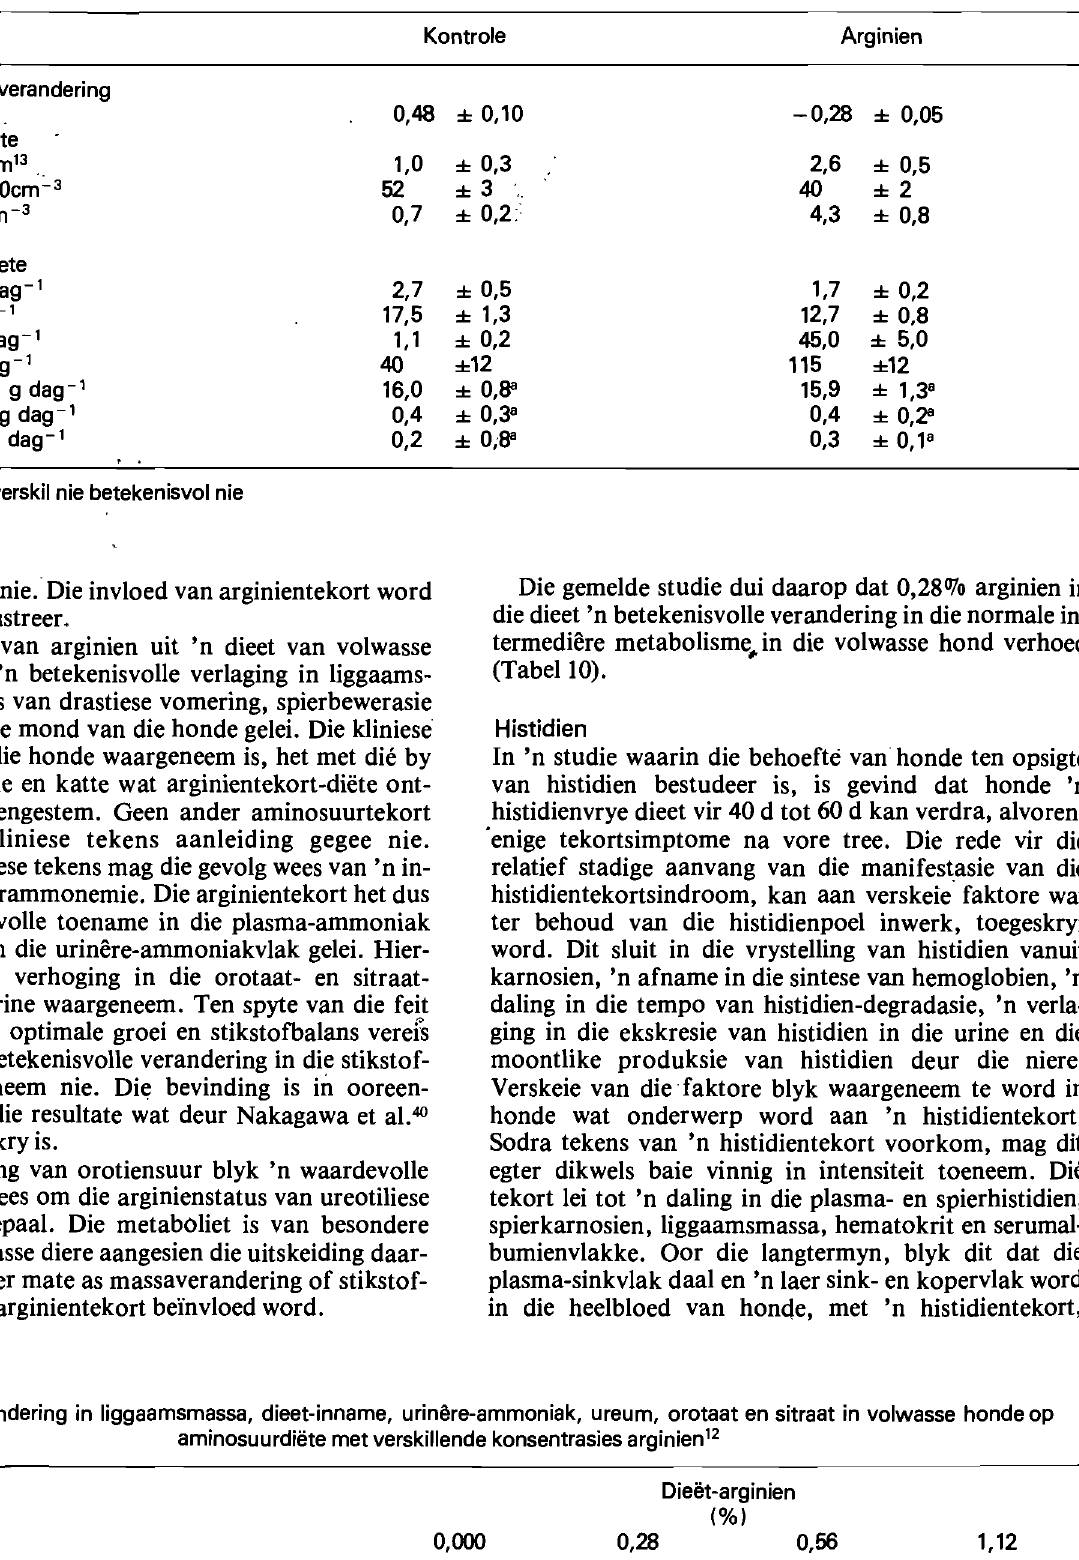
Tabel 9: Invloed van arginientekort o'p die plasma en urinere metaboliete in volwasse honde wat 2 keer per dag geforseerde voeding ontvang het 14